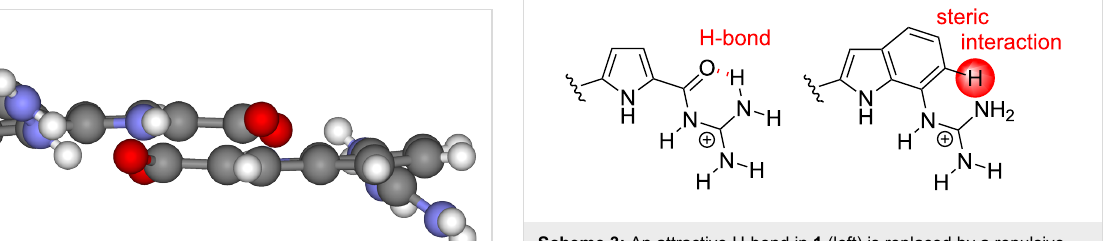
Figure 7: Side view of dimer 2 · 2 in the solid state.